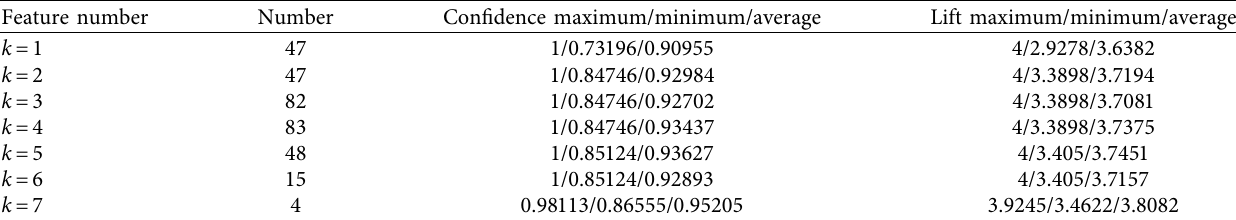
Figure 22: Average support of different frequent feature pattern discriminant criterion. Table 13: Fault diagnosis rule extraction results based on the confidence-lift framework.